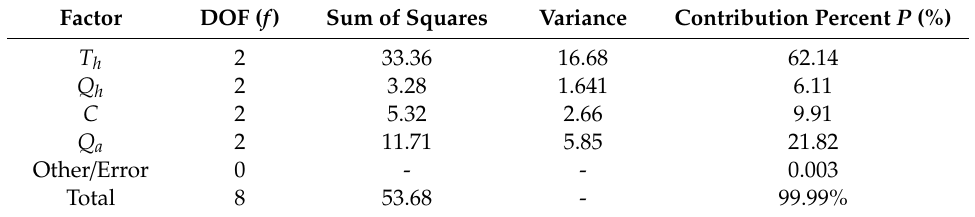
Table 5. The results of analysis of variance